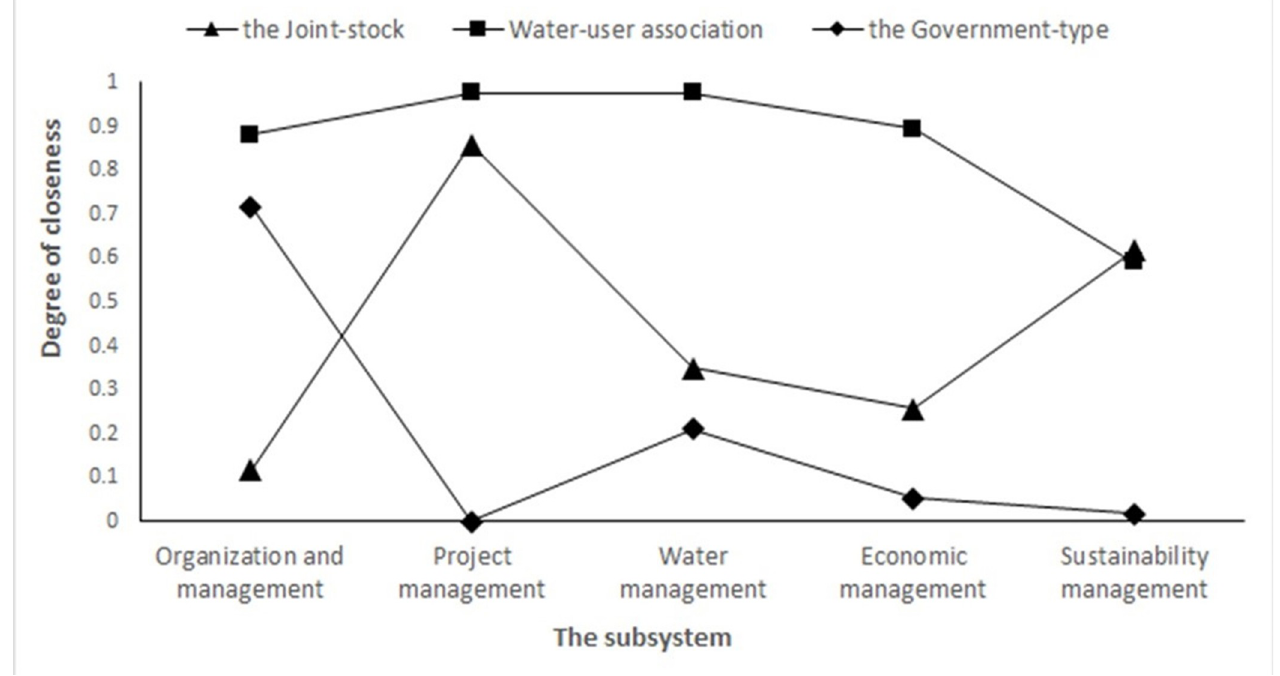
Fig 1. Comparison of closeness degrees under three management modes.